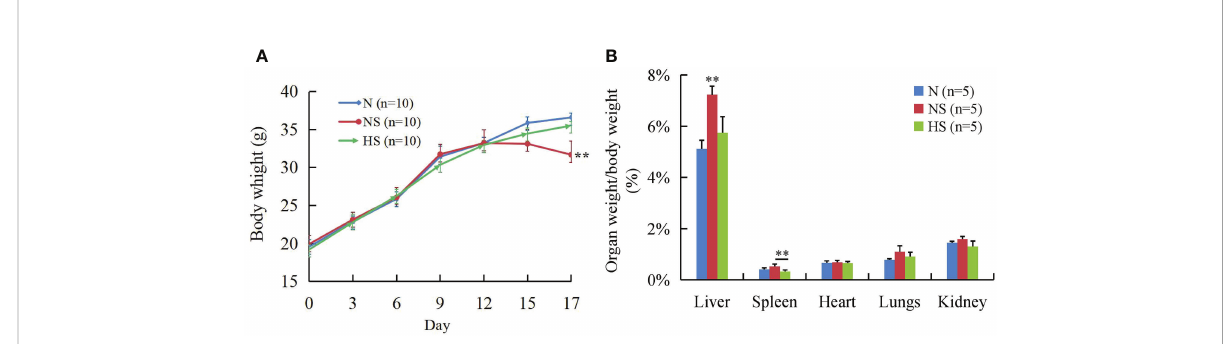
FIGURE 1 Effect of T. bellirica (Gaertn.) Roxb. extract administration on body weight and organ-to-body-weight ratio after Salmonella Typhimurium challenge in mice. (A) Body weight. (B) Organ-to-body-weight ratio. The results were evaluated through one-way ANOVA. All of the data represent means ± SD. Unmarked data indicate no signi fi cant difference ( P > 0.05); ** P <